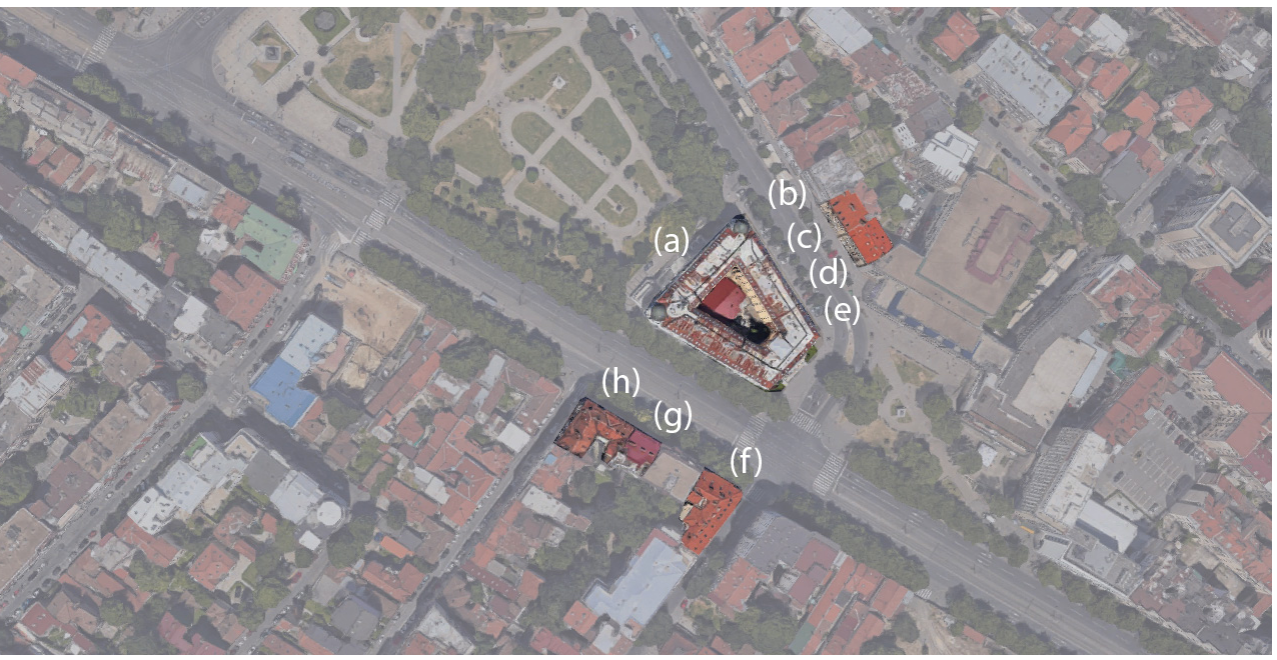
Figure 10. Belgrade case study and the eight buildings analysed.